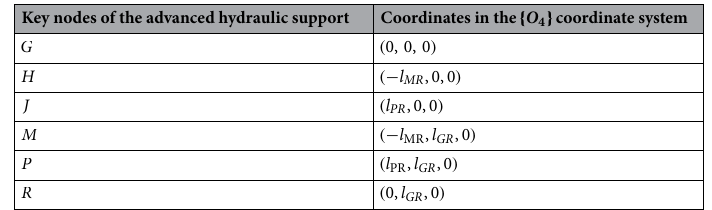
Table 7. Coordinates of nodes G , H , J , M , P , and R in the { O 4 } coordinate system.